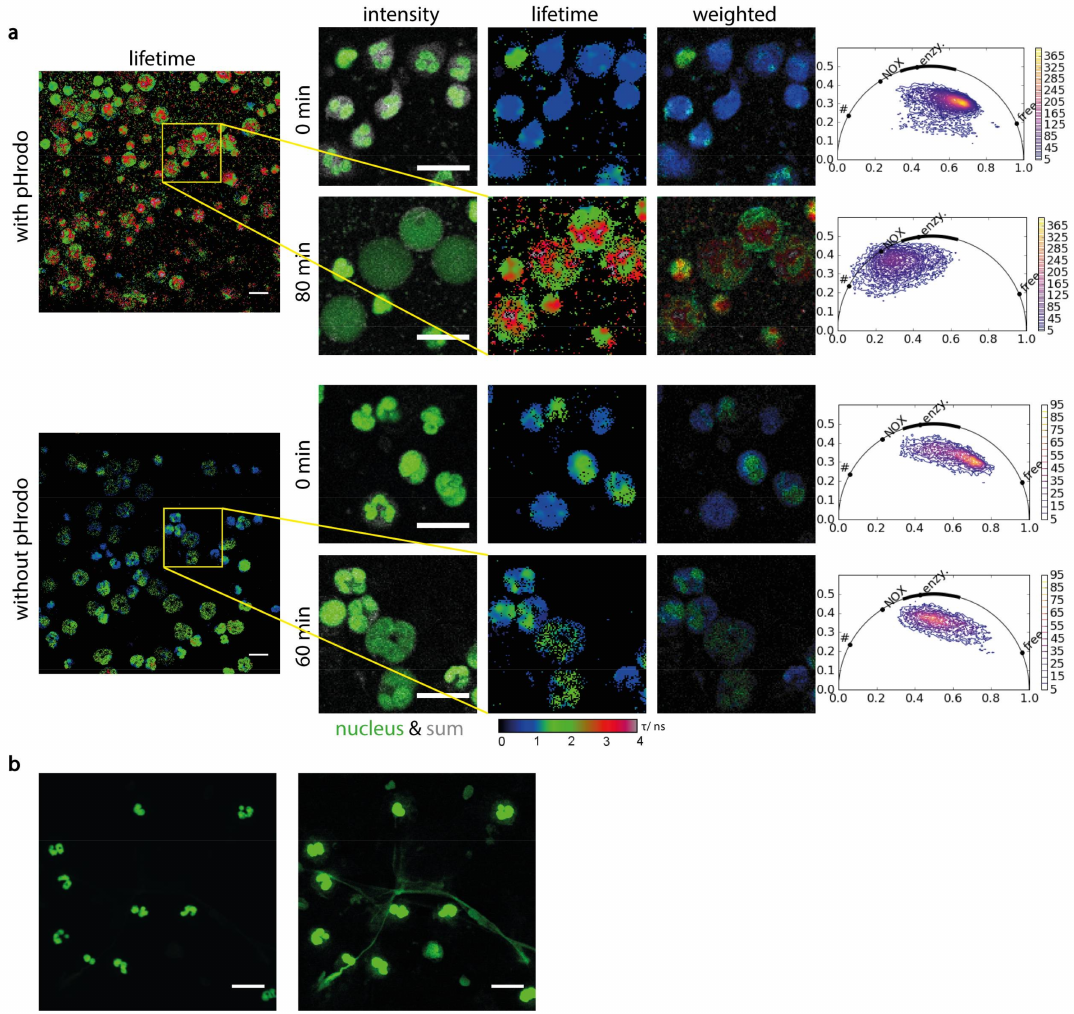
Figure 5. Orchestration of NADPH oxidase activation, cellular death and NET formation ( a ) Comparison of neutrophil metabolism in presence (first two rows) and absence (last two rows) of Staphylococcus aureus pHrodo™ beads ( n = 120 cells per individual and condition, two healthy individuals). The images were picked up at the beginning of the measurement, shortly after the pHrodo™ were added to the cells, and 80 or 60 min later. First column show the sum image (grey) merged with Vybrant DyeCycle Green™ stained DNA. The second and third column show original and intensity-weighted fluorescence lifetime images. Both the color map of FLIM images and phasor plots show the activation of NADPH oxidase in the neutrophils in presence of pHrodo™ beads after 80 min, whereas NETosis can be seen in the Vybrant DyeCycle images. The FLIM images and phasor plots of the other rows remain almost the same, even the nucleus of neutrophils in absence of the beads are slightly swollen. For better visibility, a 124 × 124 pixel area is displayed from the original 512 × 512 pixel images. The phasor plots rely on the total area of 512 × 512 pixels. ( b ) NETs after applying shear forces. DNA was stained by Vybrant DyeCycle Green™, showing in the higher-contrast image the formation of fibrous NETs. Scale bar = 20 µ m. In the phasor plots in a “free” encodes free NAD(P)H, “enzym.” NAD(P)H bound to metabolic enzymes, “NOX” NADPH bound to NADPH oxidases and “#” oxidized lipids as defined by Datta et